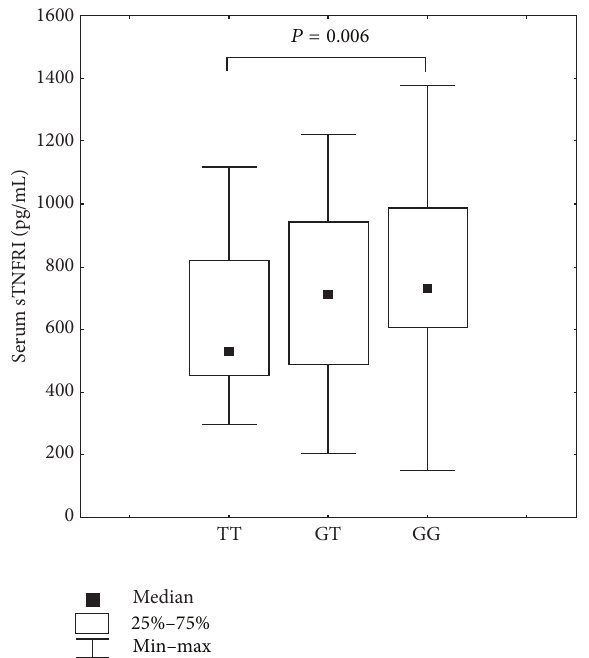
Figure 1: Serum levels of soluble TNF 𝛼 type I receptor from indi- viduals presenting with different SNP TNFRI − 609G/T (rs4149570) polymorphisms. Kruskall-Wallis 𝐻 test, 𝑃 = 0.032 , Mann-Whitney 𝑈 test: TT versus GG, 𝑃 = 0.006 .